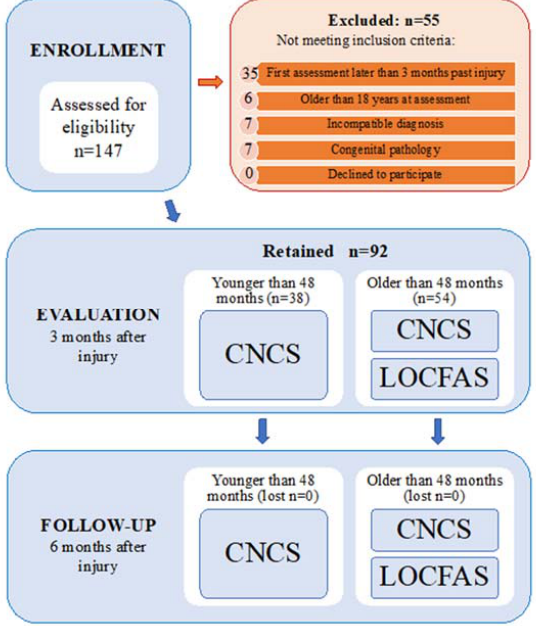
Figure 1. Flow diagram of the study indicating enrollment, exclusions, and group allocation. CNCS: Rappaport Coma / Near Coma Scale; LOCFAS: Level of Cognitive Functioning Assessment